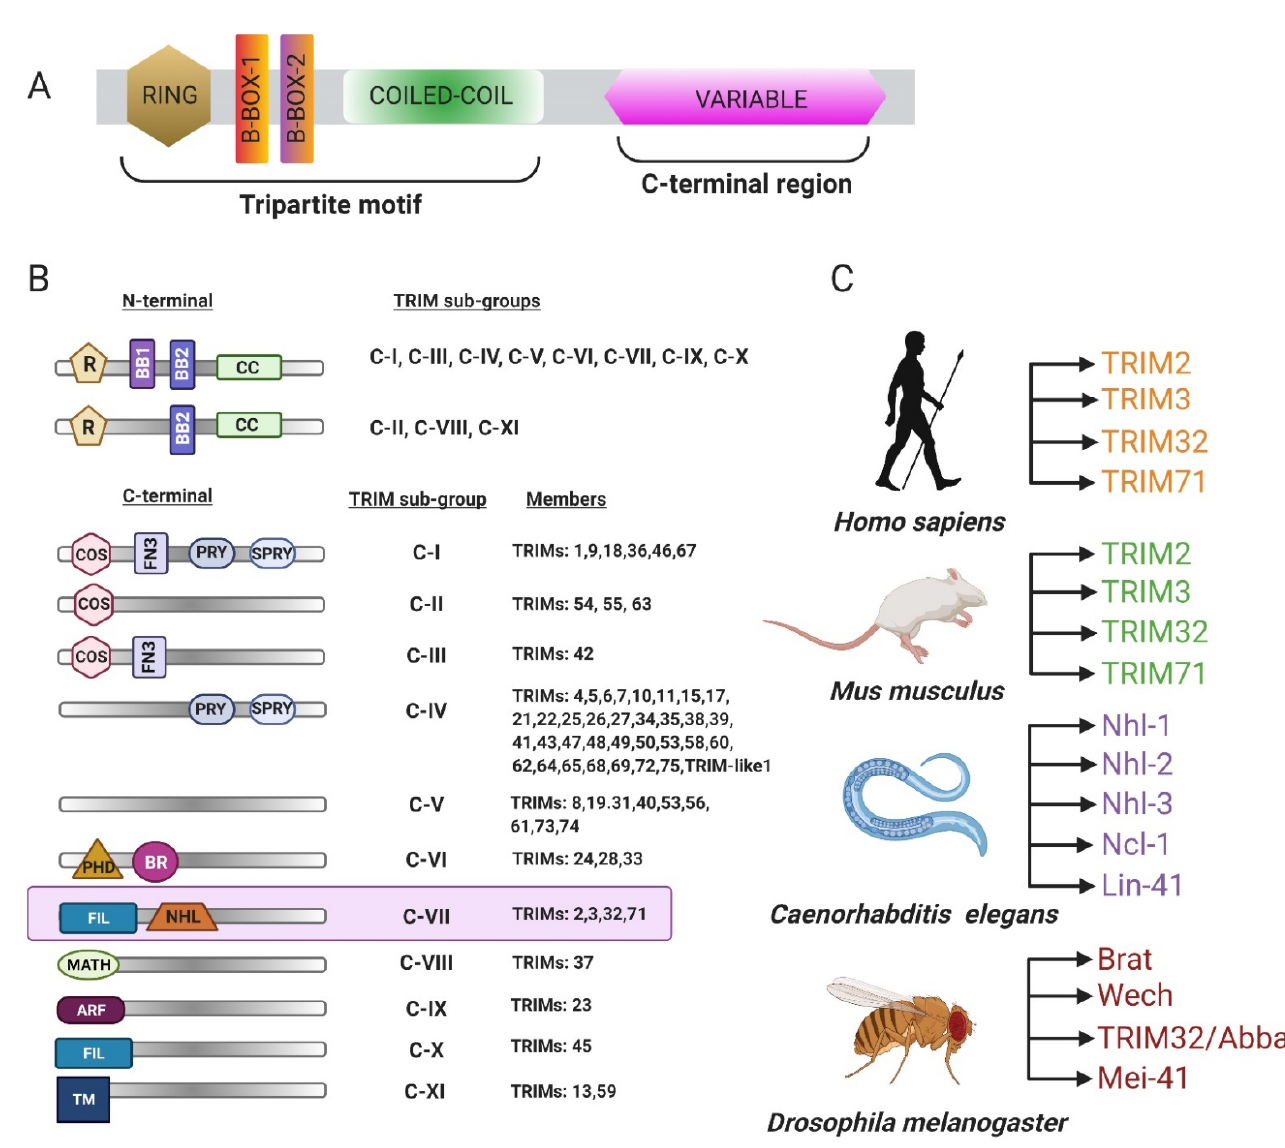
Figure 1. Classification of the tripartite motif family of proteins 32 (TRIM). ( A ) General schematic of a TRIM protein. The N-terminus is comprised of a really interesting new gene (RING) domain, one or two B-box regions, and a coiled-coil domain followed by a variable C-terminus. ( B ) Table representing different categories of TRIM proteins. ( C ) Different NHL (NCL-1, HT2A, LIN-41) proteins encoded in vertebrates and invertebrates (adapted from WILLIAMS et al. 2019).